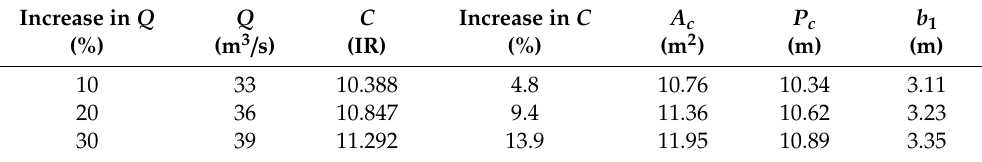
Table 7. Sensitivity of construction cost to changes in the design